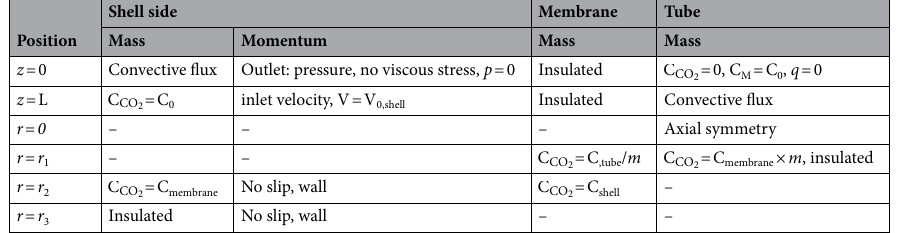
Table 5. The boundary conditions of governing equations.